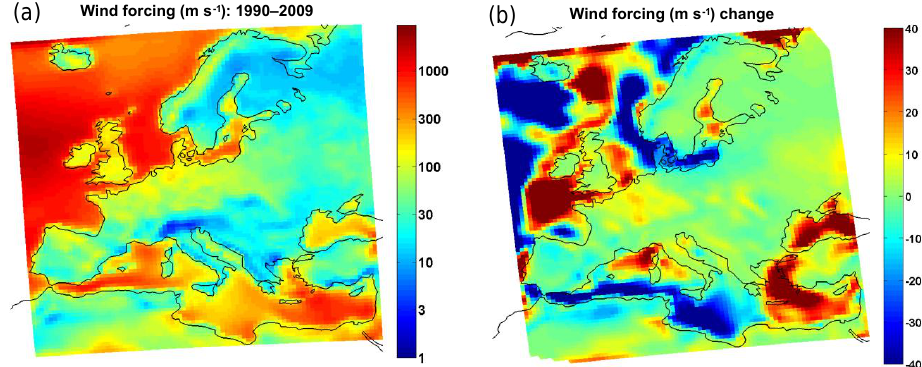
Figure 3. Wind forcing ( ≈ U 3 . 41 ). (a) Past period (1990–2009); (b) absolute difference between the future (2040–2059) and past 10